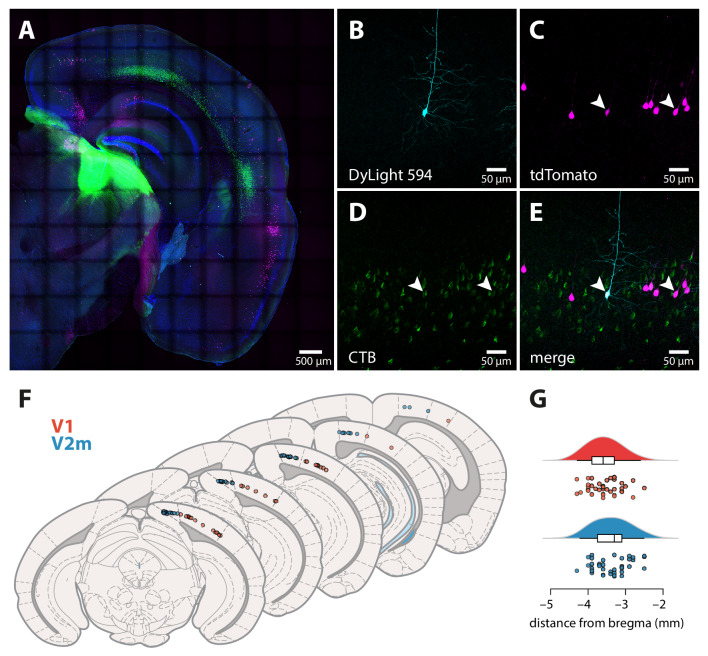
Identification of ttL5 neurons and recording locations in V1 and V2m.(A) Coronal slice containing visual cortex and LP, showing the injection site and retrogradely labelled neurons (green), tdTomato-expressing Colgalt2-Cre neurons (magenta), a DAPI stain (blue), and neurons that have been filled with biocytin during intracellular recordings and stained with DyLight 594 (cyan). (B) Biocytin-filled ttL5 neuron in V2m. (C) Neighbouring tdTomato-expressing Colgalt2-Cre neurons. (D) CTB-labelled L5 neurons projecting to LP. (E) Composite image of the above. Arrowheads highlight two example cells labelled by both tdTomato and CTB. (F) Schematic of coronal sections, adapted from Franklin and Paxinos, 2007, showing approximate mediolateral locations of V1 (red) and V2m (blue) neurons recorded in the cfADP experiments (90 out of the 129 neurons recorded in total). For visualization, neurons were projected onto the closest of the five atlas sections shown. (G) Approximate anteroposterior locations of the neurons relative to bregma.